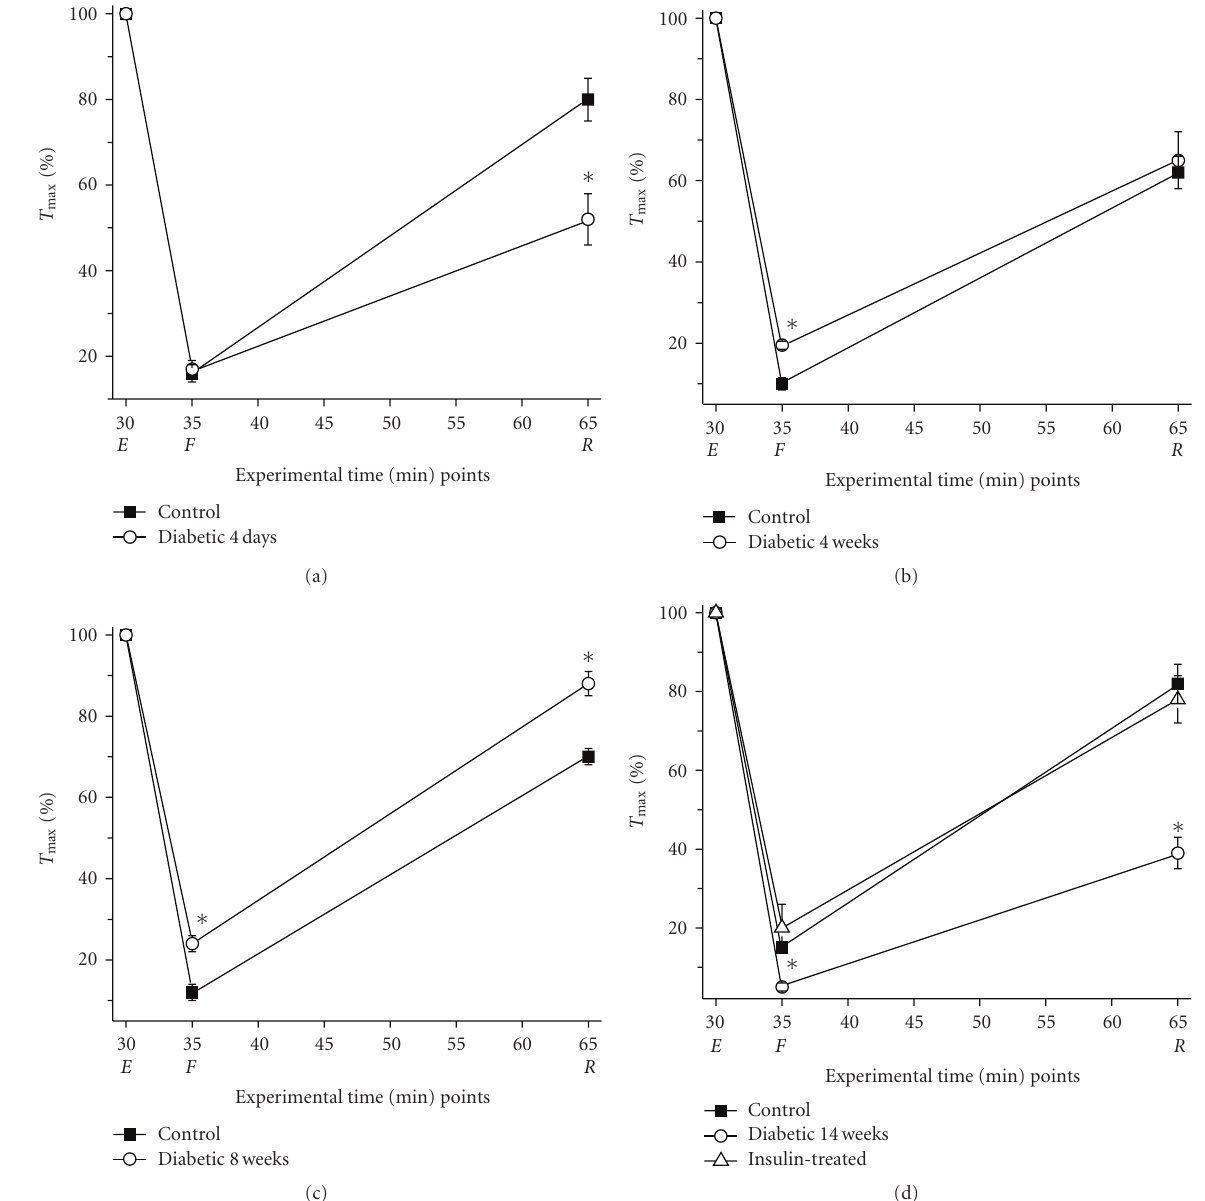
Figure 2: Temporal adaptation of intact diaphragm (DPH) muscle contractile function in diabetic muscles. All data are presented as the mean ± SD. (a) Diabetes exerts an acute deleterious e ff ect on DPH contractile function that is reverted with time (b and c) and profoundly deteriorates with the progression of diabetes (d). After 2 weeks of insulin treatment DPH contractile function significantly improves to levels comparable to control levels (d). In all panels, closed squares show data for control muscles, open circles for diabetic muscles, and the open triangle represents the diabetic + insulin treatment. ∗ means P < .05. T max , number of experiments and statistical details are presented in Table 1 and